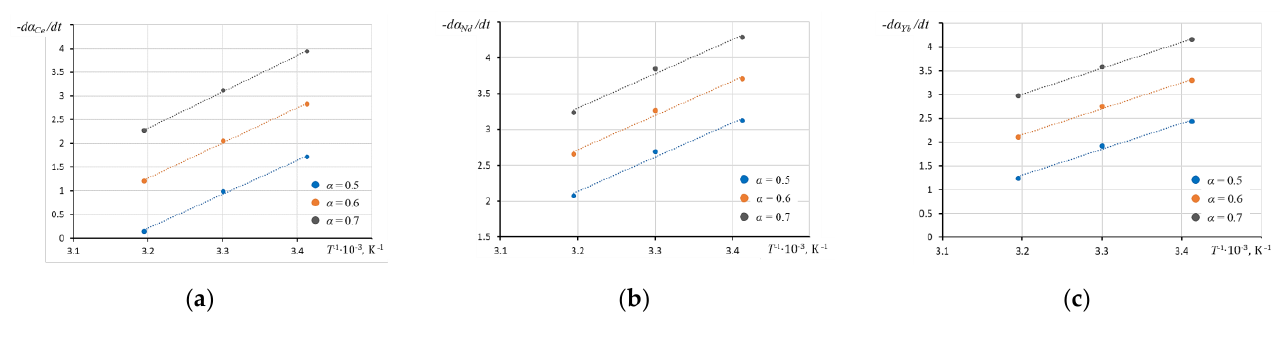
Figure 7. Leaching rate versus return temperature: ( a ) for Ce; ( b ) for Nd; ( c ) for Yb. Linear dependencies are approximated by the equations shown in Table 8, with an approximation validity value of at least 98%. Table 8. Linear approximation of leaching data.